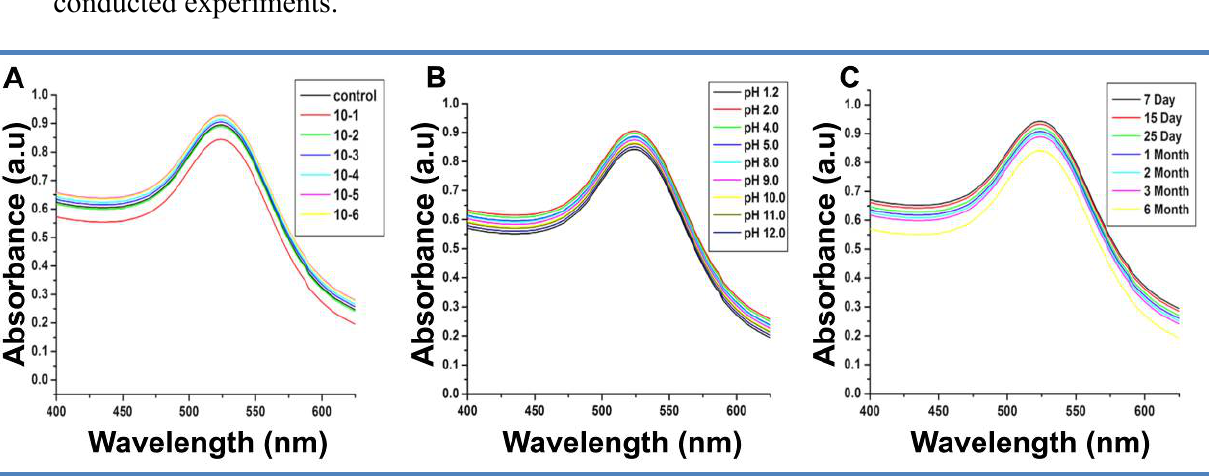
Figure 2. UV-visible spectra of AuNPs depicting their high stability due to the influence of CMC capping. Stability of CMC stabilized AuNPs were tested against ( A ) different electrolytic (NaCl) concentration; ( B ) Varied pH conditions; and ( C ) Six month stability study showing no aggregation. The data is representative of three independently conducted